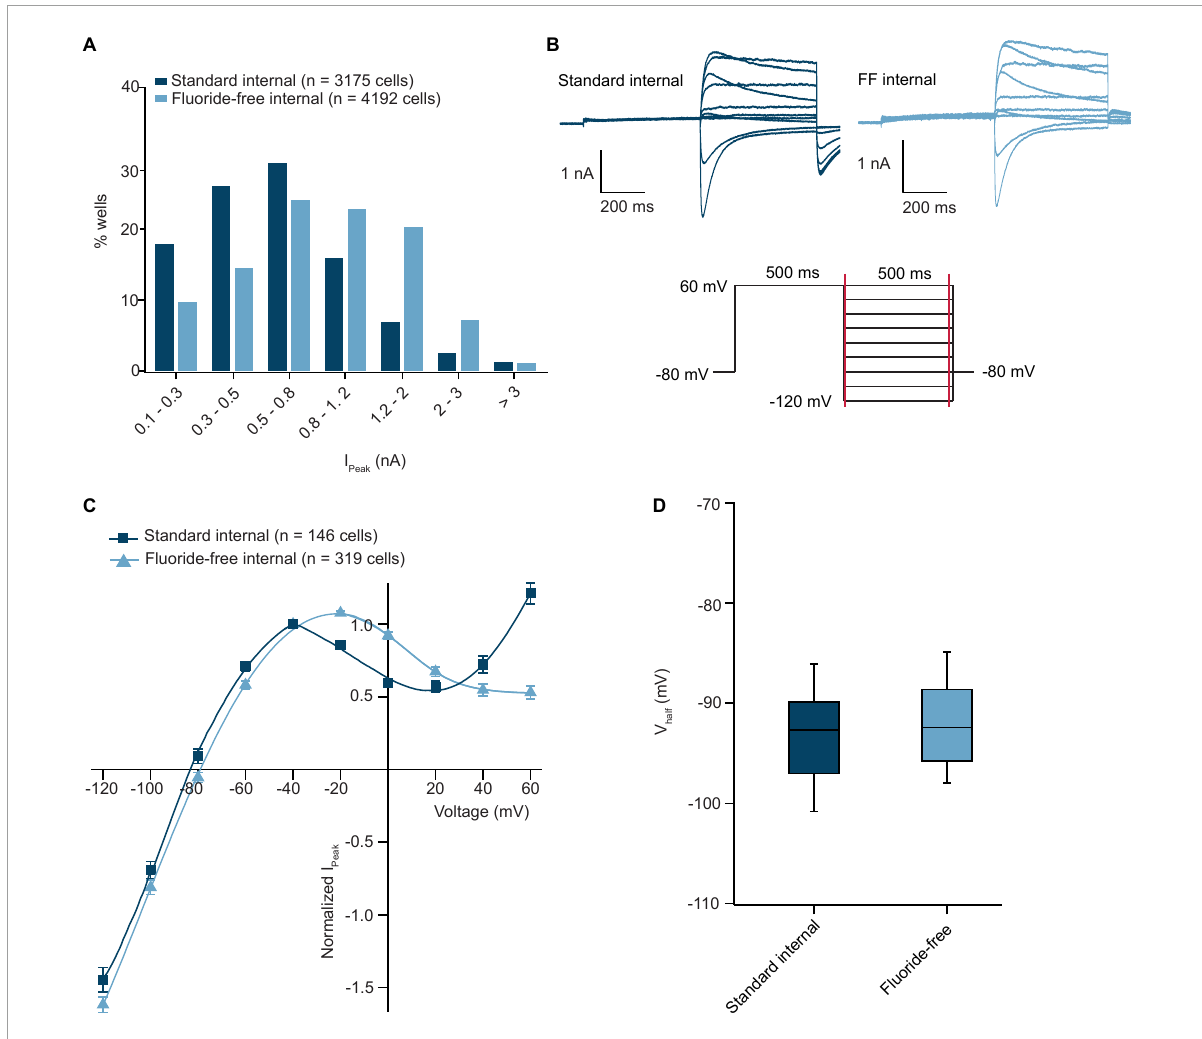
FIGURE2 hERG currents in standard internal and fluoride-free internal solution. (A) Histogram plot of I Peak values for standard internal and fluoride-free internal. There was a tendency to higher peak amplitudes in fluoride-free internal solution vs. standard internal. (B) Current-voltage traces of hERG using standard internal (left) and fluoride-free internal (right). The voltage protocol is shown underneath. (C) IV curves for an average of 146 cells in standard internal and 319 cells in fluoride-free solution are shown overlaid. A standard Boltzmann equation (see Section “Data analysis”) was used to fit the curve from –120 to –20 mV. (D) V half values for hERG recorded in standard internal and fluoride-free internal. The V half values of 190 cells in standard internal and 261 cells in fluoride-free internal were not significantly different using a Student’s t -test ( P >